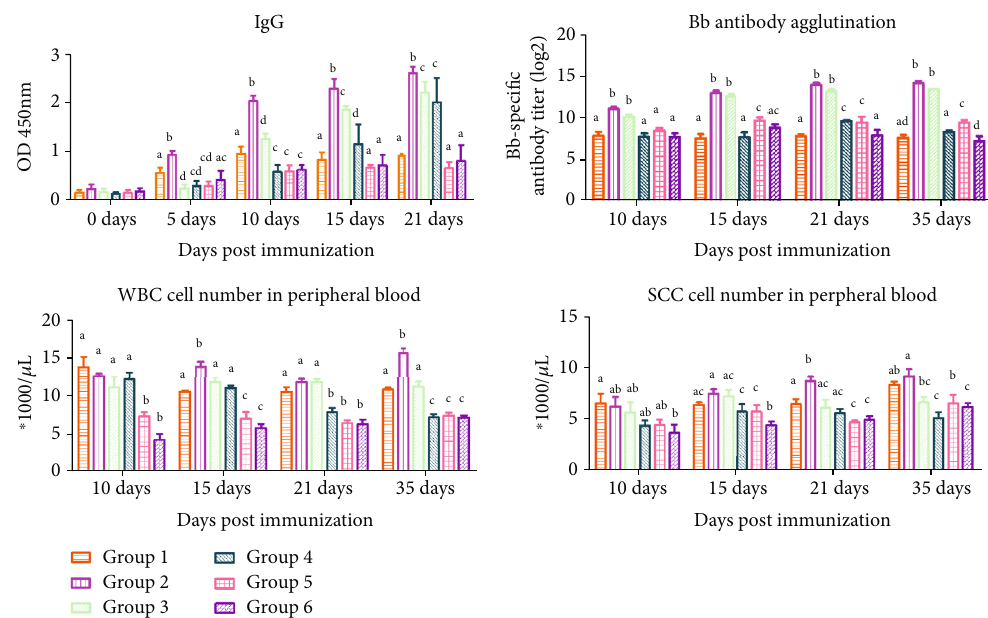
Figure 1: The serum level of whole bacterial protein-speci fi c IgG antibody in rabbits from Experiment A was detected by indirect ELISA. An agglutination test was performed to measure B . bronchiseptica -speci fi c antibody titer. Blood samples were collected from each group of rabbits as anticoagulants at 10, 15, 21, and 35 days postimmunization for the detection of WBC and